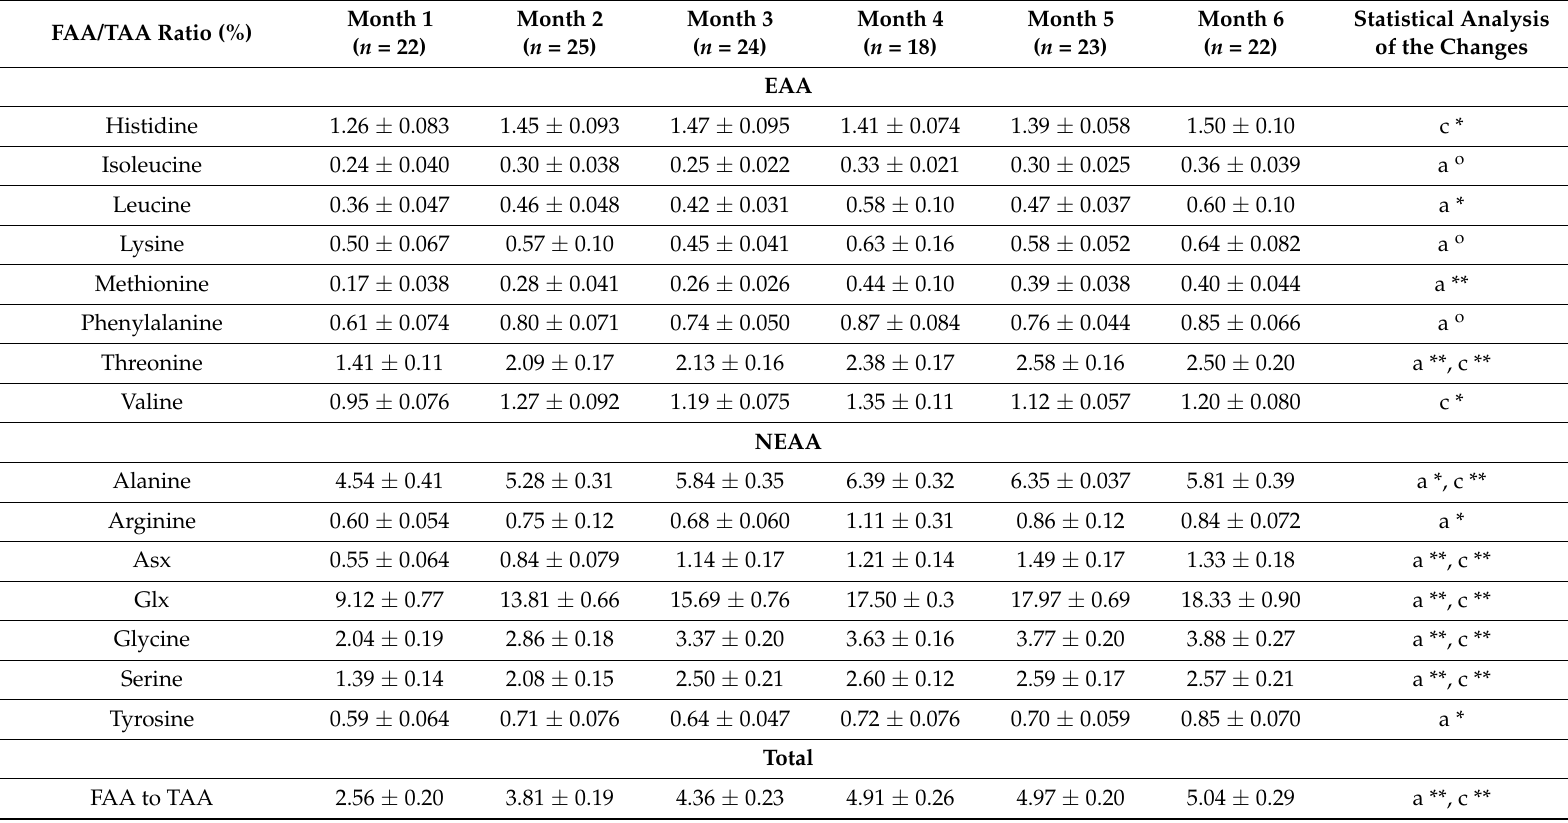
Table 4. Percentage of free amino acids relative to total amino acids in human milk in months 1–6 of lactation. FAA/TAA Ratio